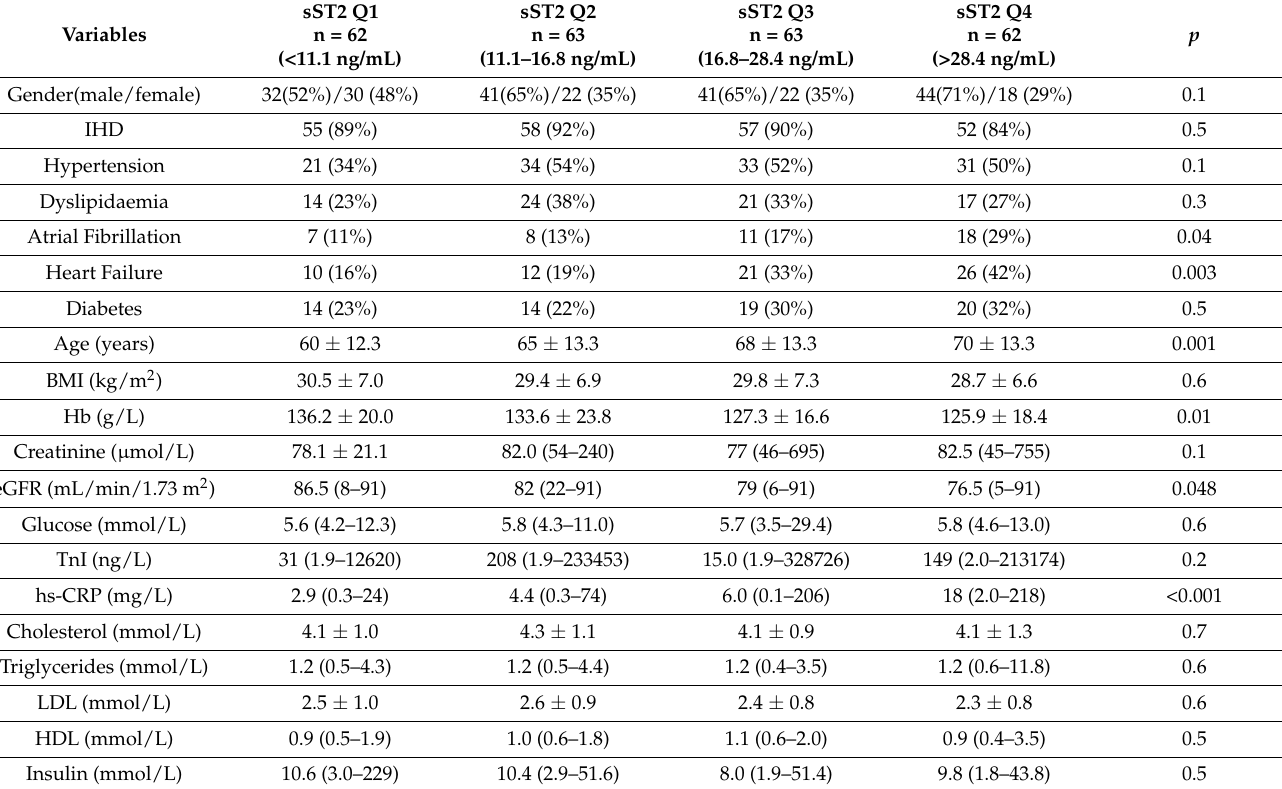
Table 5. Patient’s characteristics and biochemistry levels comparisons by sST2 quartiles (statistics: Kruskal–Wallis H test or Chi-square test, as